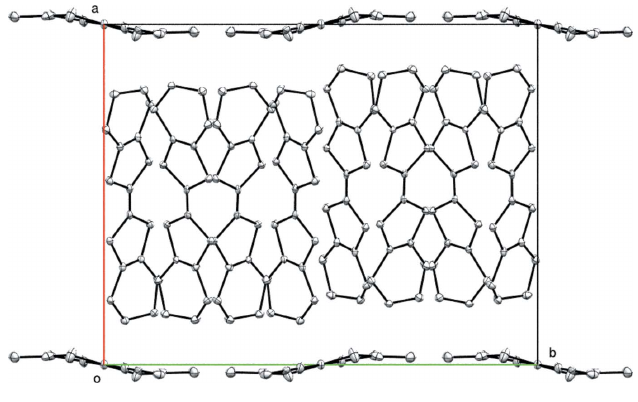
Figure 5 View of the structural arrangement of (BEDT-TTF) 4 [Cu(NCS) 4 ], showing layers of BEDT-TTF molecules parallel to (001) separated by layers of [Cu(NCS) 4 ] 2– dianions.